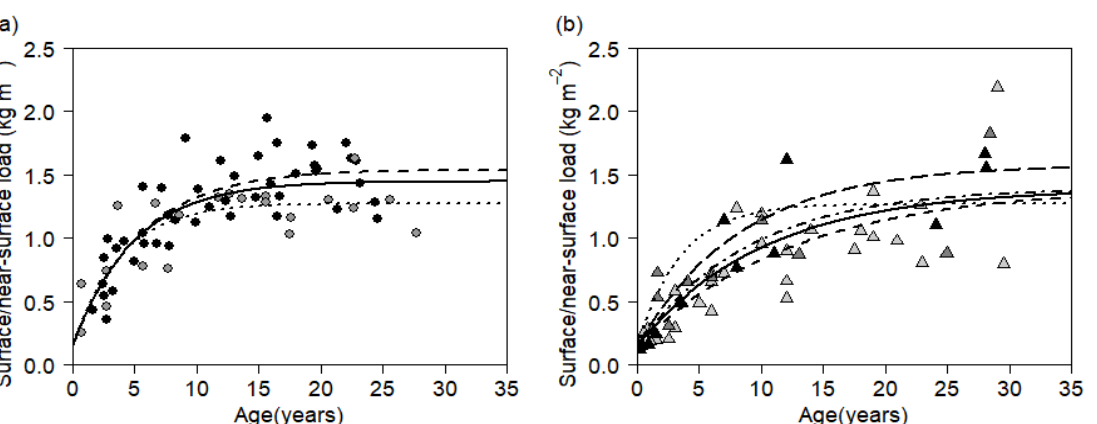
Figure 3. Modelled surface/near-surface fuel load accumulation curves and data for NE and SE sites. ( a ) NE sites: E. amygdalina/E. sieberi —black circles and dashed line, E. obliqua —grey circles and dotted line, NE combined model—solid line; ( b ) SE sites: E. pulchella —black triangles and long dashed line, E. globulus —dark grey triangles and dot dash line, E. amygdalina/E. tenuiramus —light grey triangles and dashed line, A. verticillata —open triangles and dotted line, SE combined eucalypt model—solid line. Table 4. Parameters for surface/near-surface fuel load models. Standard errors are shown in parentheses. Region